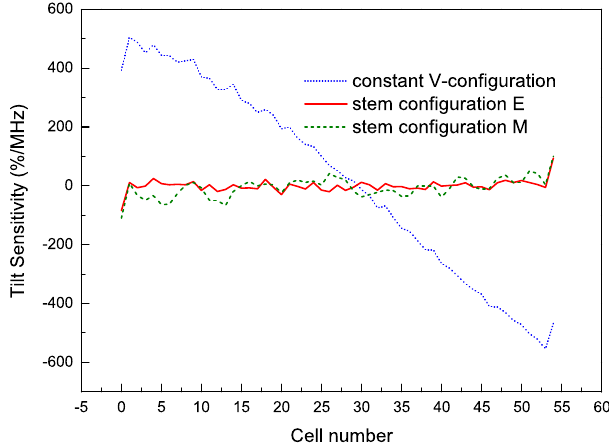
FIG. 19. Simulated field tilt sensitivity of the operational mode as defined in Eq. (21) of an Alvarez-type cavity for different stem configurations. The applied perturbations are described in the text. Blue: a constant V-configuration without stabilization through stem rotation. Red: stabilization through stem configuration E of Fig. 16. Green: stabilization through stem configuration M of Fig.